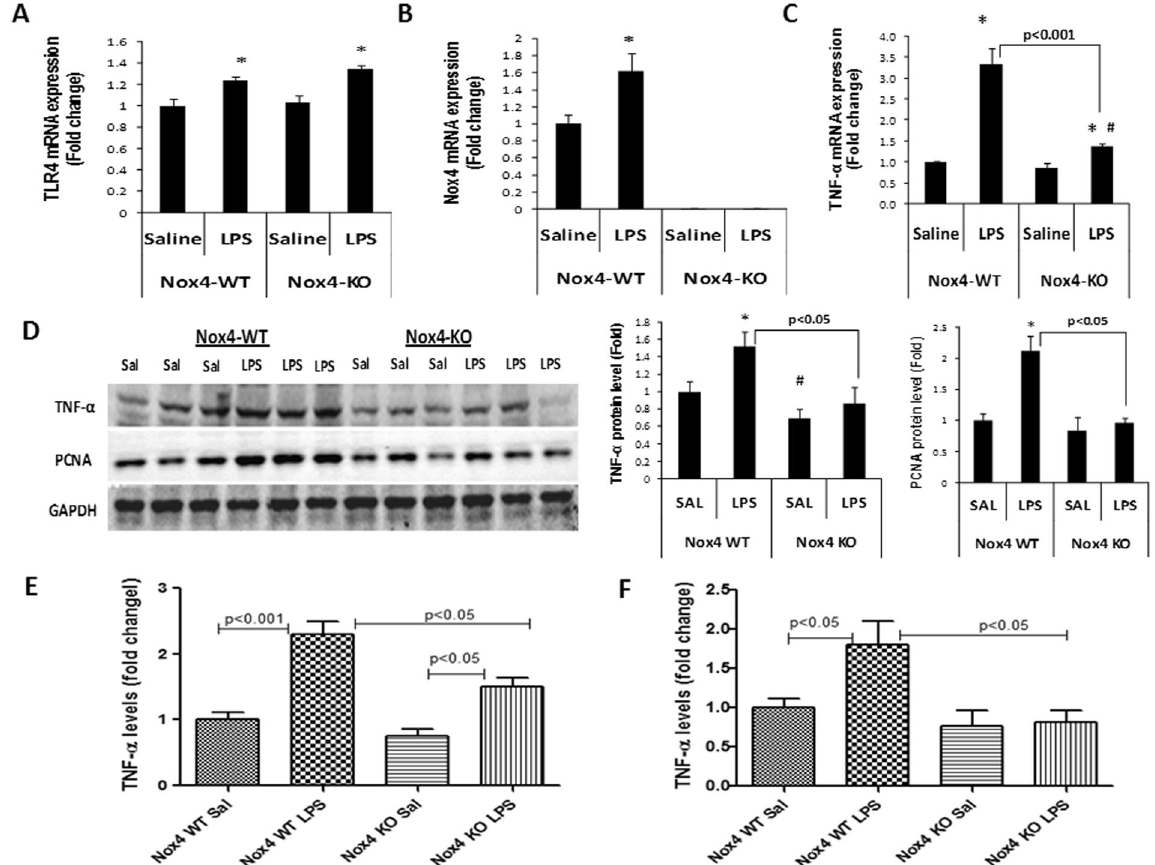
Figure 7. LPS induced TNF- α and PCNA levels subsided in the liver of Nox4 KO mice with six weeks of repeated LPS stimulation. Wild type and Nox4 KO mice were either injected with saline or LPS for up to 6 weeks (once a week), and TNF- α , Nox4 and PCNA levels were analyzed in the liver samples. ( A ) Liver samples (n = 3) of each group were analyzed for TLR4 mRNA expression. ( B ) Analysis of Nox4 mRNA levels in the liver samples (n = 3) of all groups. ( C ) TNF- α mRNA expression were analyzed in the liver samples of wild type (n = 7, in each group) groups and Nox4 KO (n = 5, in each group) groups. ( D ) Western blot analysis of TNF- α and PCNA protein levels in liver samples (n = 3) of all groups. ( D ) Densitometry analysis of TNF- α and PCNA protein levels normalized with GAPDH in liver samples (n = 3) of each group are shown. ( E , F ) TNF- α levels were analyzed in the plasma samples (n = 3) of wild type and Nox4 KO mice groups injected with saline or LPS either for 24 hrs ( E ) or up to 6 weeks ( F ) of repeated stimulation. * indicates statistically significant difference from the corresponding controls (p < 0.05). # indicates statistically significant difference from Nox4 WT saline groups (p < 0.05). Lines with p values also indicate statistically significance (p < 0.05) between the